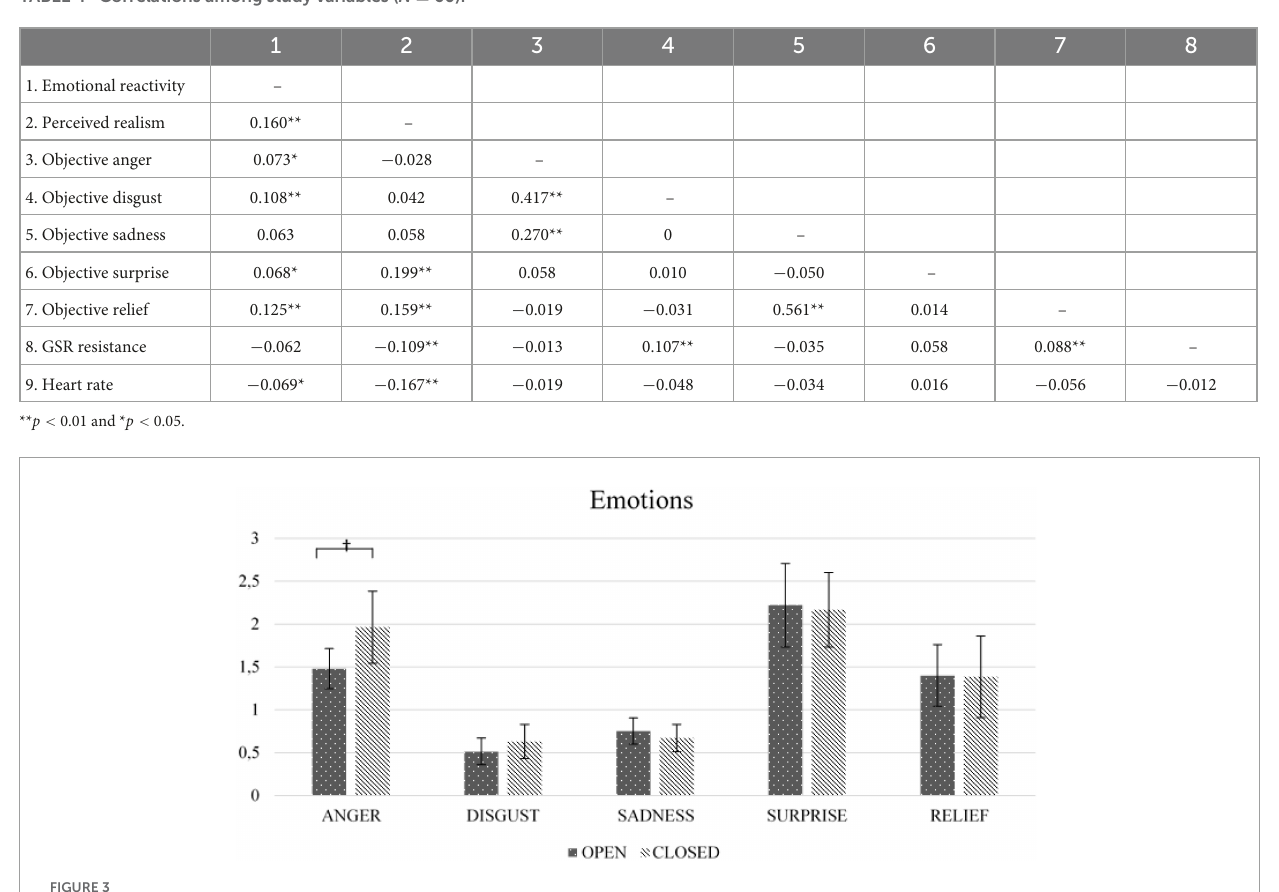
interviewers in real time. We found differences between open and closed questions for the emotion of anger, as well as for GSR and HR. Also, as expected, general emotionality and perceived realness of the simulation made some of the emotional reactions